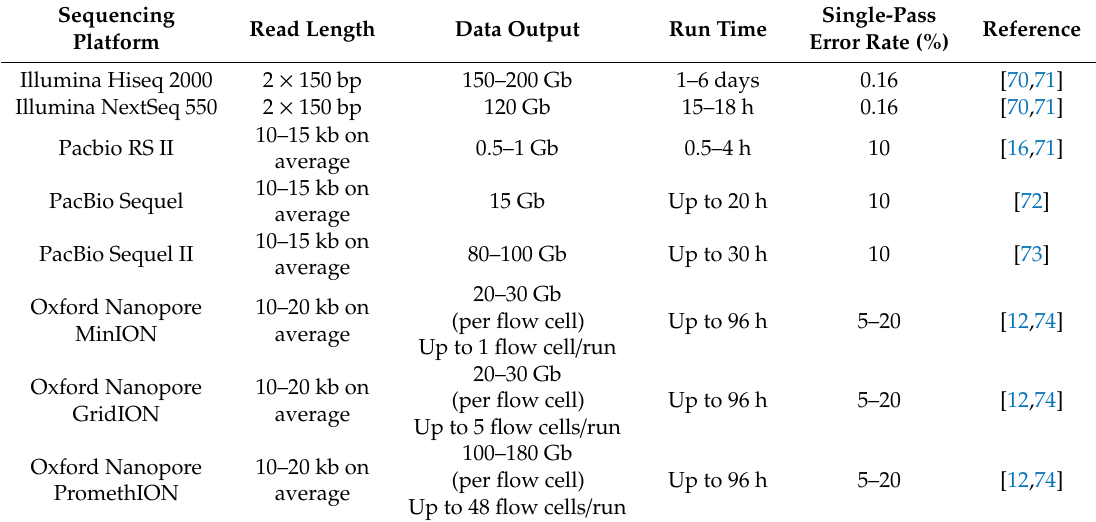
Table 1. Comparison of bench top second-generation sequencers as well as some of PacBio’s and ONT’s platforms.